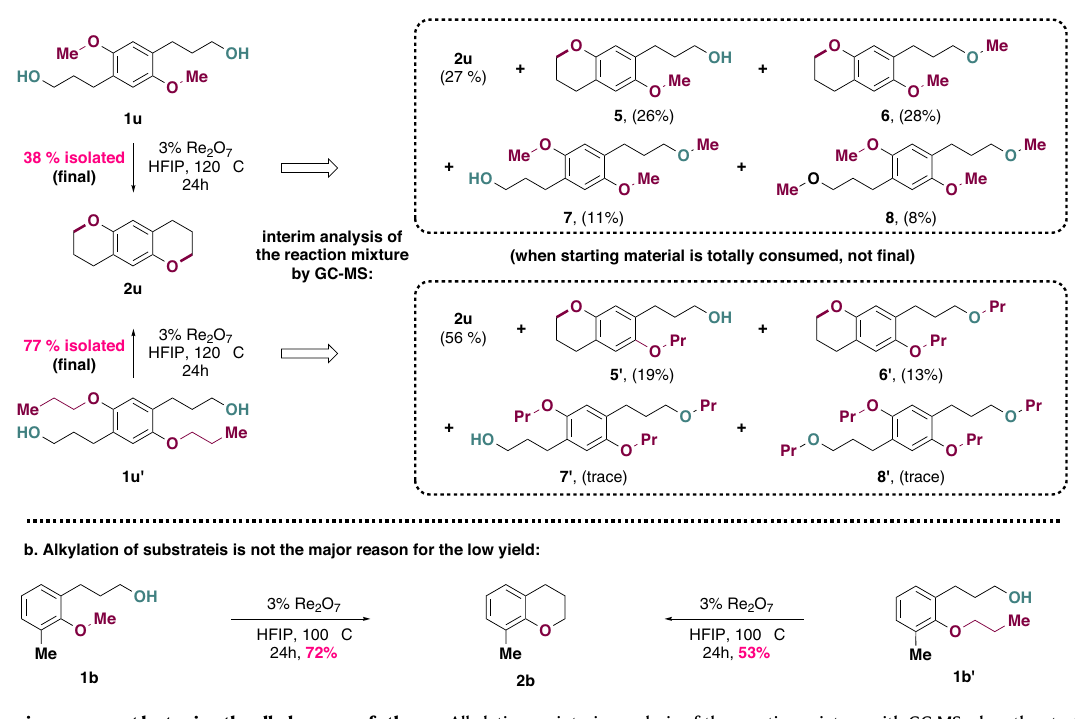
interim analysis of the reaction mixture with GC-MS when the starting material is totallyconsumed. 5 and 5 ’ couldfurthercyclizetogivethedesiredproduct,while 6 and 6 ’ , 7 and 7 ’ , 8 and 8 ’ are dead-end